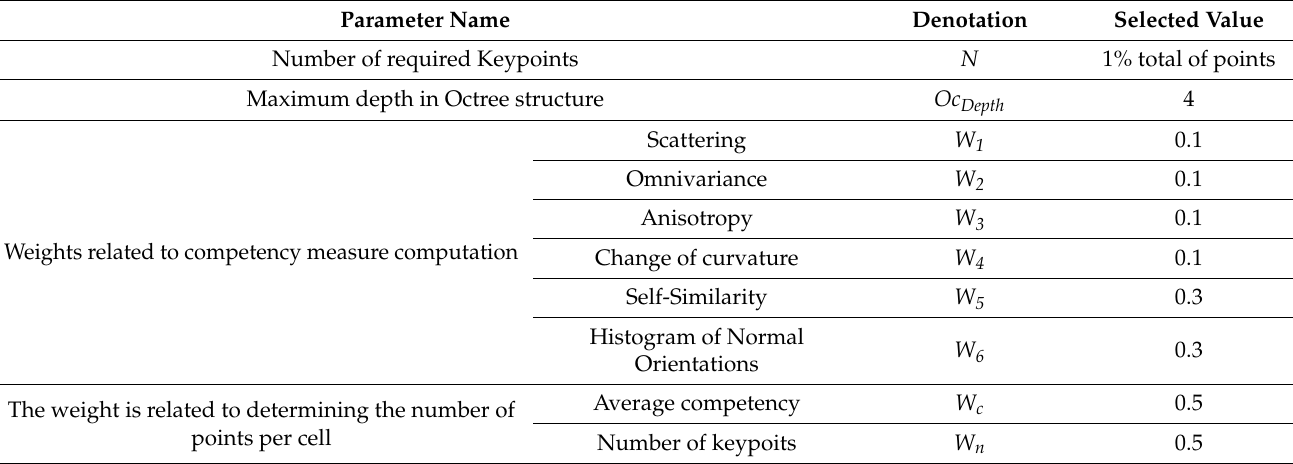
Table 1. The parameters of the 3D Keypoints detection